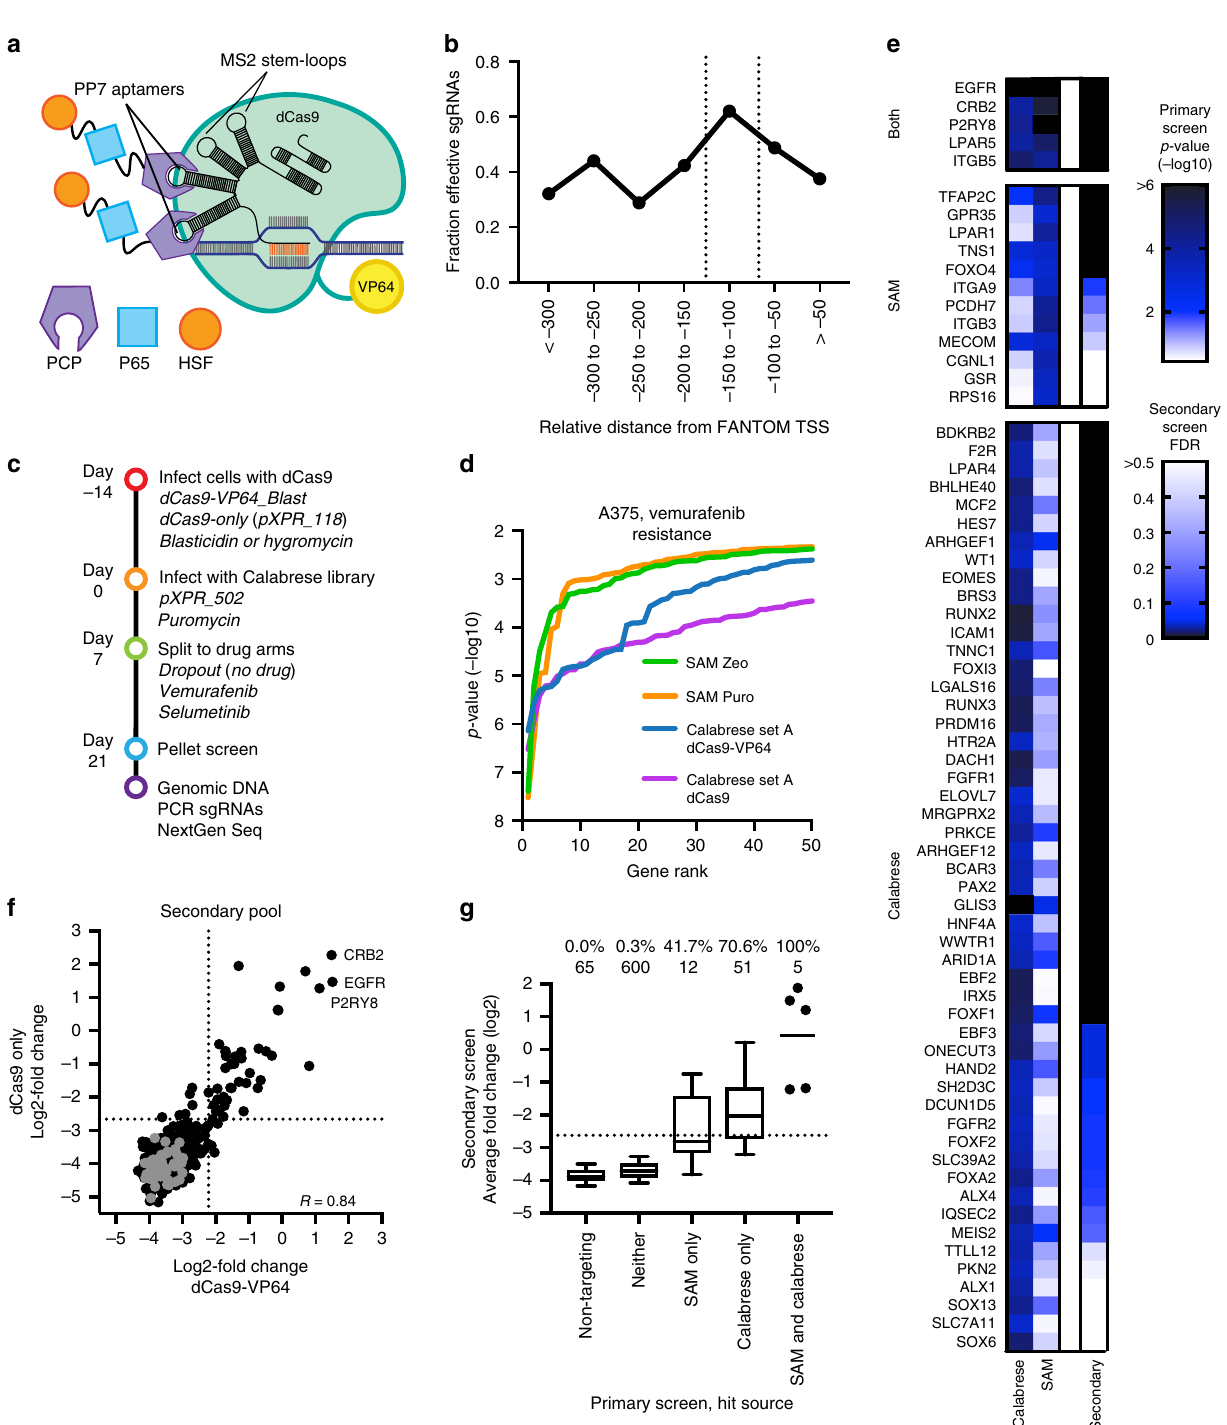
Fig. 5 CRISPRa screening with Calabrese. a Schematic of CRISPRa components. b Comparison of sgRNA activity as a function of distance from annotated transcription start site (TSS). Vertical dotted lines indicate the preferred targeting window. c Schematic of screens performed with Calabrese. d Distribution of the p -values calculated using a hypergeometric distribution equivalent to a one-sided Fisher ’ s exact test for the top 50 genes in vemurafenib resistance screens in A375 cells with the SAM and Calabrese libraries. e Comparison of the primary screen p -values calculated as in d and secondary screen false discovery rates (FDR). All genes shown scored with p -value < 10 − 3 in either the Calabrese or SAM primary screen, and are grouped accordingly. f Comparison of the average log2-fold change values for all sgRNAs targeting a gene for each of two dCas9 constructs screened with a secondary pool. Sets of non-targeting control sgRNAs are gray; dotted lines represent a 5% FDR cutoff. The gene-level Pearson correlation is indicated. g Validation rate for genes grouped by the primary screen(s) in which they scored. Dotted line indicates FDR <5%. The fraction of genes above this cutoff is reported, as well as the total number of genes in each category. The box represents the 25th, 50th, and 75th percentiles; whiskers show 10th and 90th percentiles. For the category with 5 genes, individual values are plotted and the mean